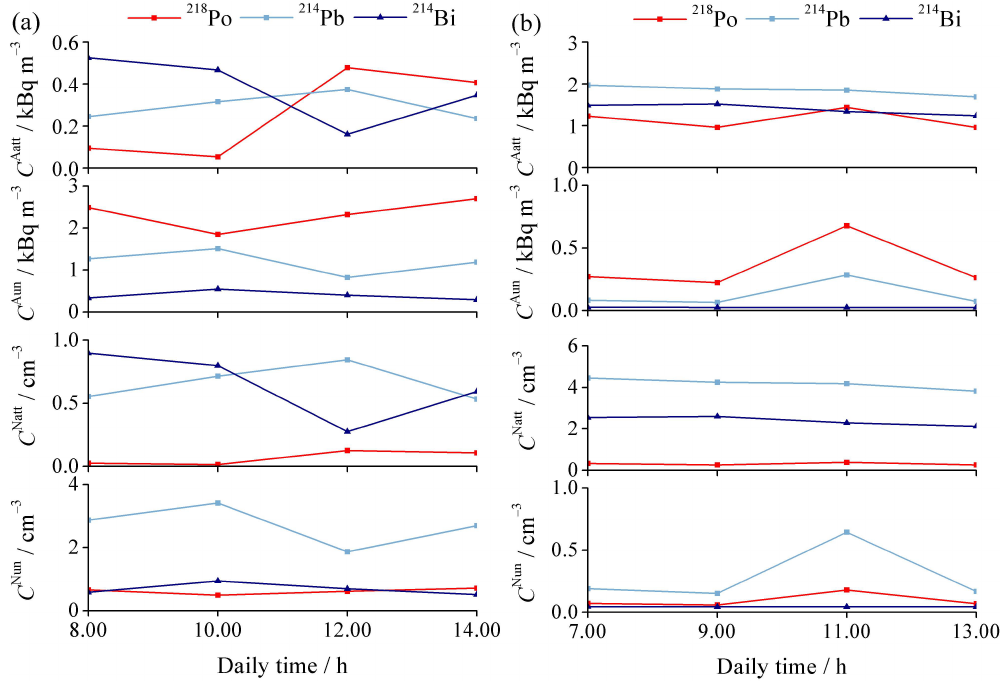
Fig. 5. Activity concentrations and number concentrations of 218 Po, 214 Pb and 214 Bi in the time interval of Fig. 4, when background aerosols were also monitored, from top to bottom: activity concentrations in the unattached form ( C Aun in the attached form ( C Aatt concentrations in the attached form ( C Natt